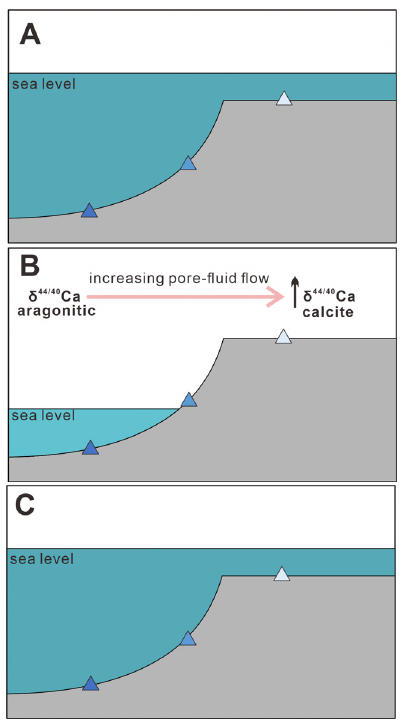
Figure 6. Simulated geochemical changes during sea level fall in the Chibi region ( A ) Before the Late Permian sea level decline, ( B ) Late Permian sea level decline and ( C ) Early Triassic sea level rebound. The colorful triangles represent the carbonate section.